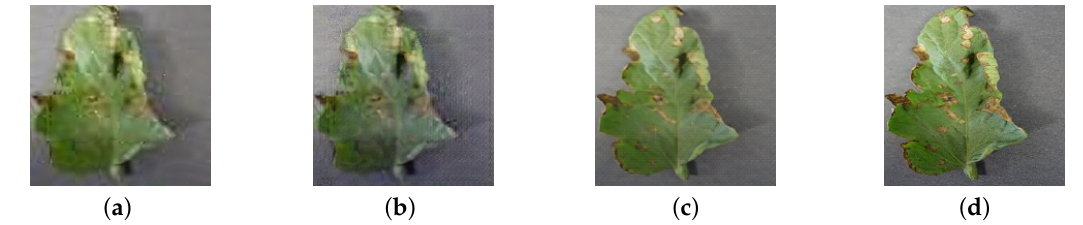
Figure 6. Visual comparison of super-resolution (SR) images generated from three training stages. ( a ) is from the pre-trained G pre based on ImageNet, ( b ) is from G 1 after the first fine-tuning and ( c ) is from G 2 after the second fine-tuning. ( d ) is the original high-resolution (HR) image.